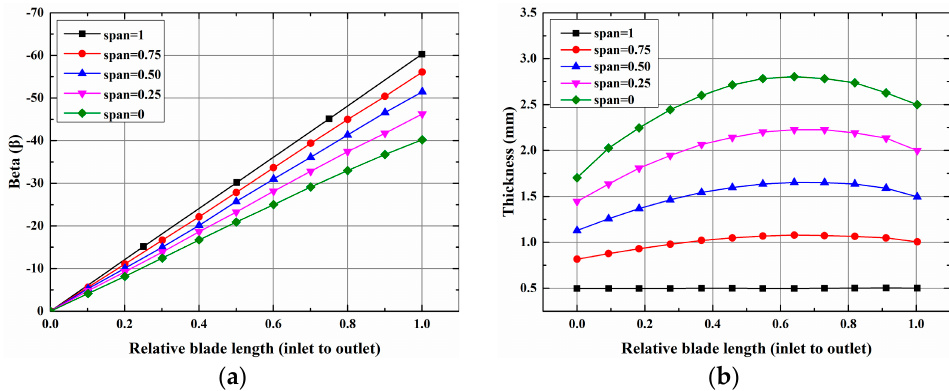
Figure 4. Blade parameters of impeller: ( a ) Blade angle distribution; ( b ) blade thickness distribution. Table 4. Impeller design